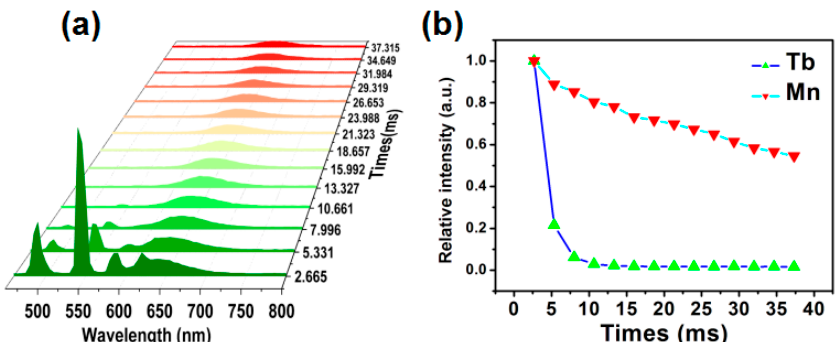
Figure 7. ( a ) Time-resolved spectroscopy of sample the CTP:0.1Mn 2+ ; and ( b ) the change in the trend of relative intensity of Tb 3+ and Mn 2+ over come.